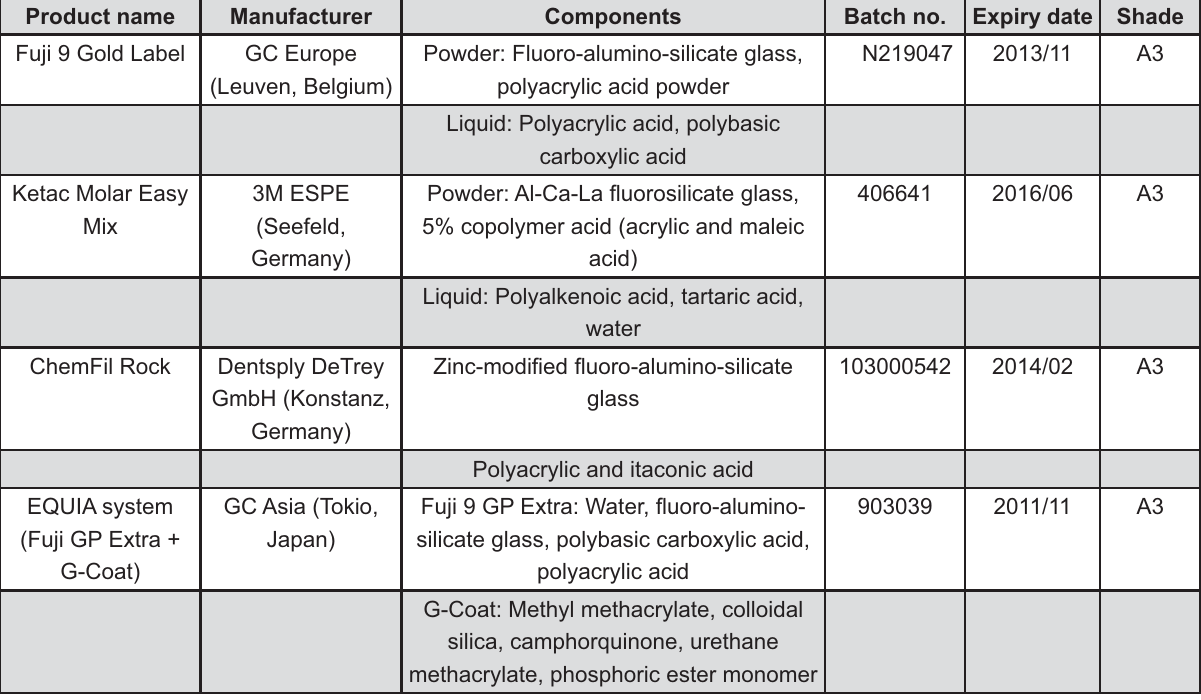
Figure 1- Product name, manufacturer, composition, batch number, expiration date and shade of the materials